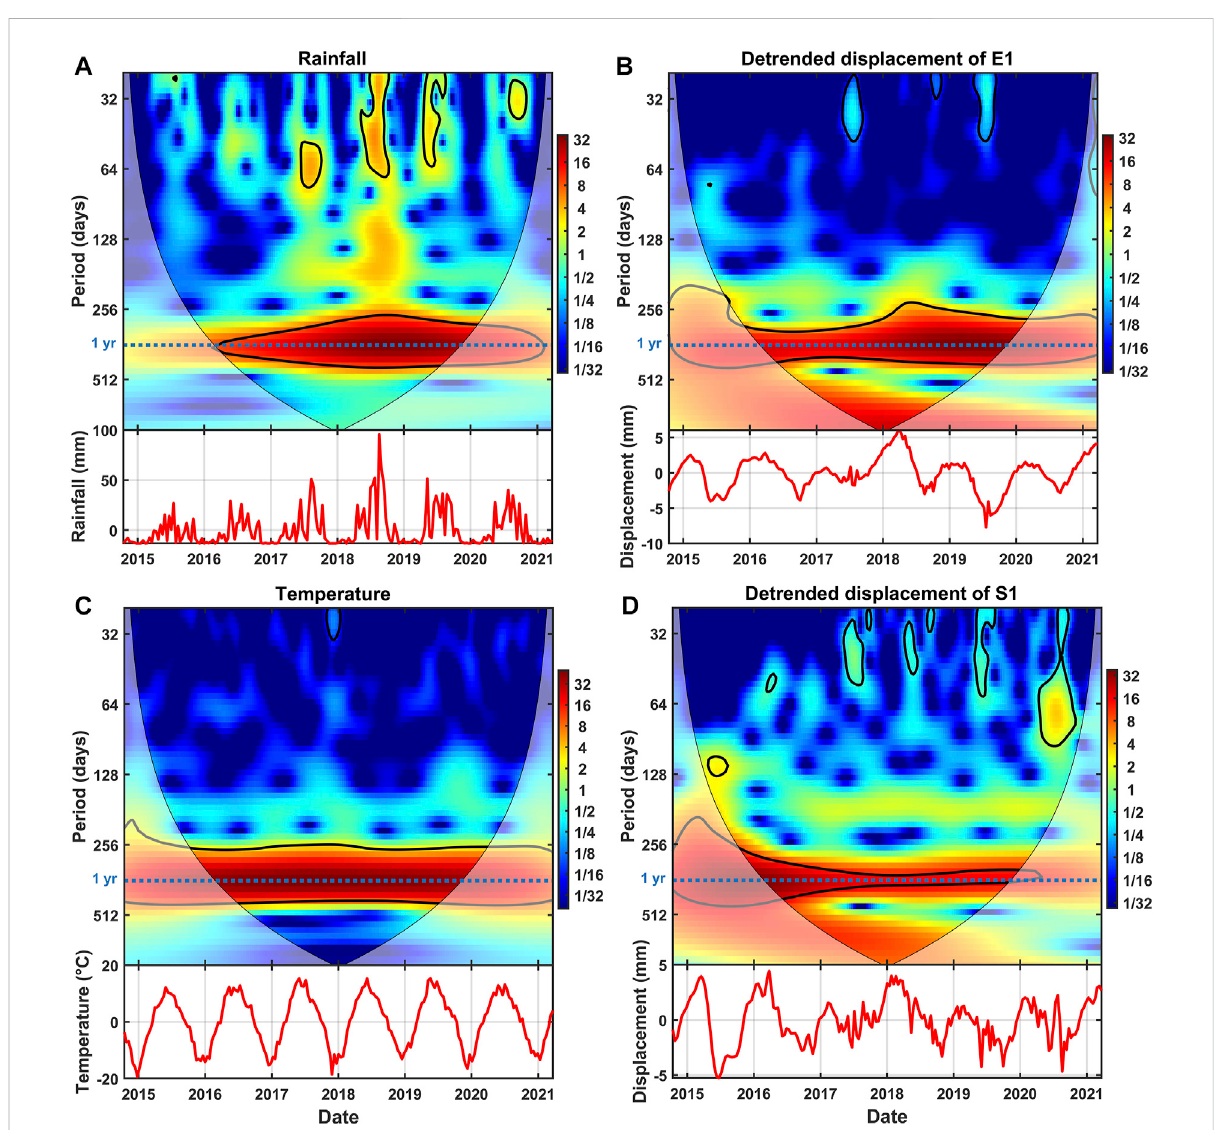
Continuous wavelet power spectrums for different time-series data: (A) precipitation, (B) detrended displacement of E1, (C) air temperature, and (D) detrended displacement of S1. The positive values in deformation time series mean approaching to the satellite. The thick black contours indicate the 5% signi fi cant level against red noise. The areas with half-transparent masks designate the cone of in fl uence (COI) where the results are unreliable due to the nonnegligible edge effects. We use the same style for Figures 10 –